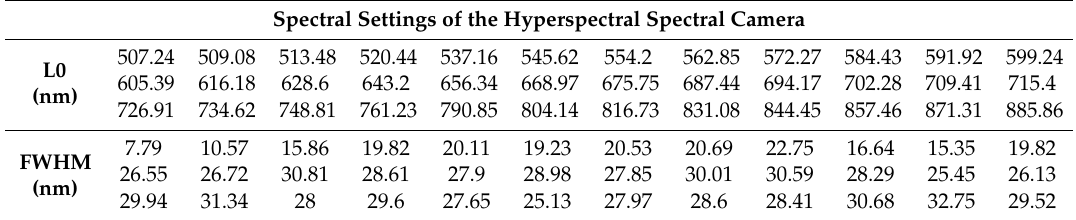
Table 2. Spectral settings of the hyperspectral spectral camera. L0: Central wavelength, FWHM: Full width at half